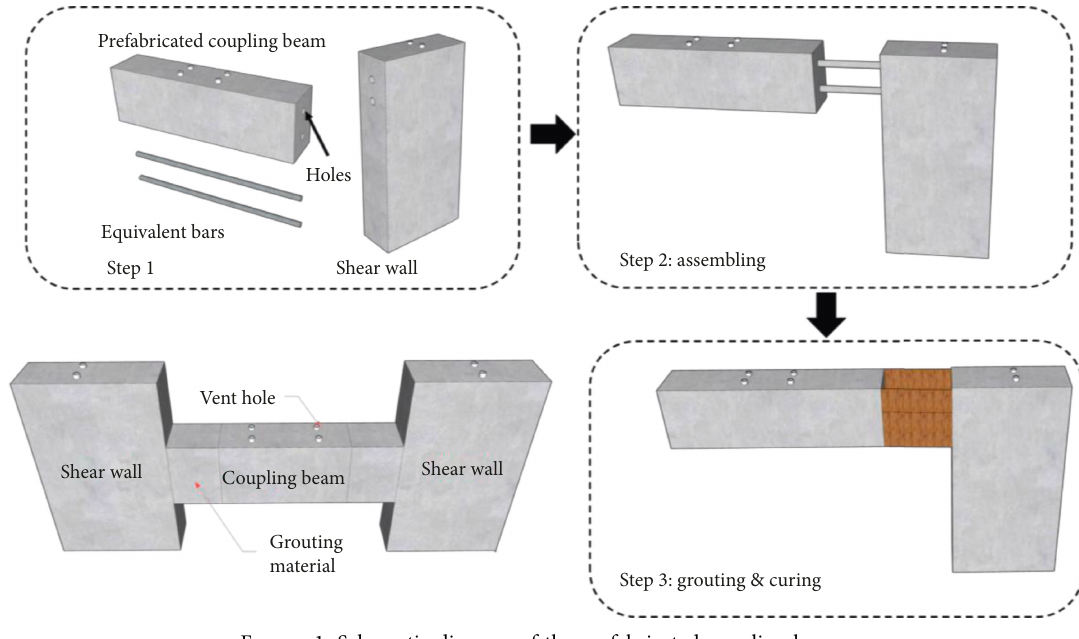
Figure 1: Schematic diagram of the prefabricated coupling beam.